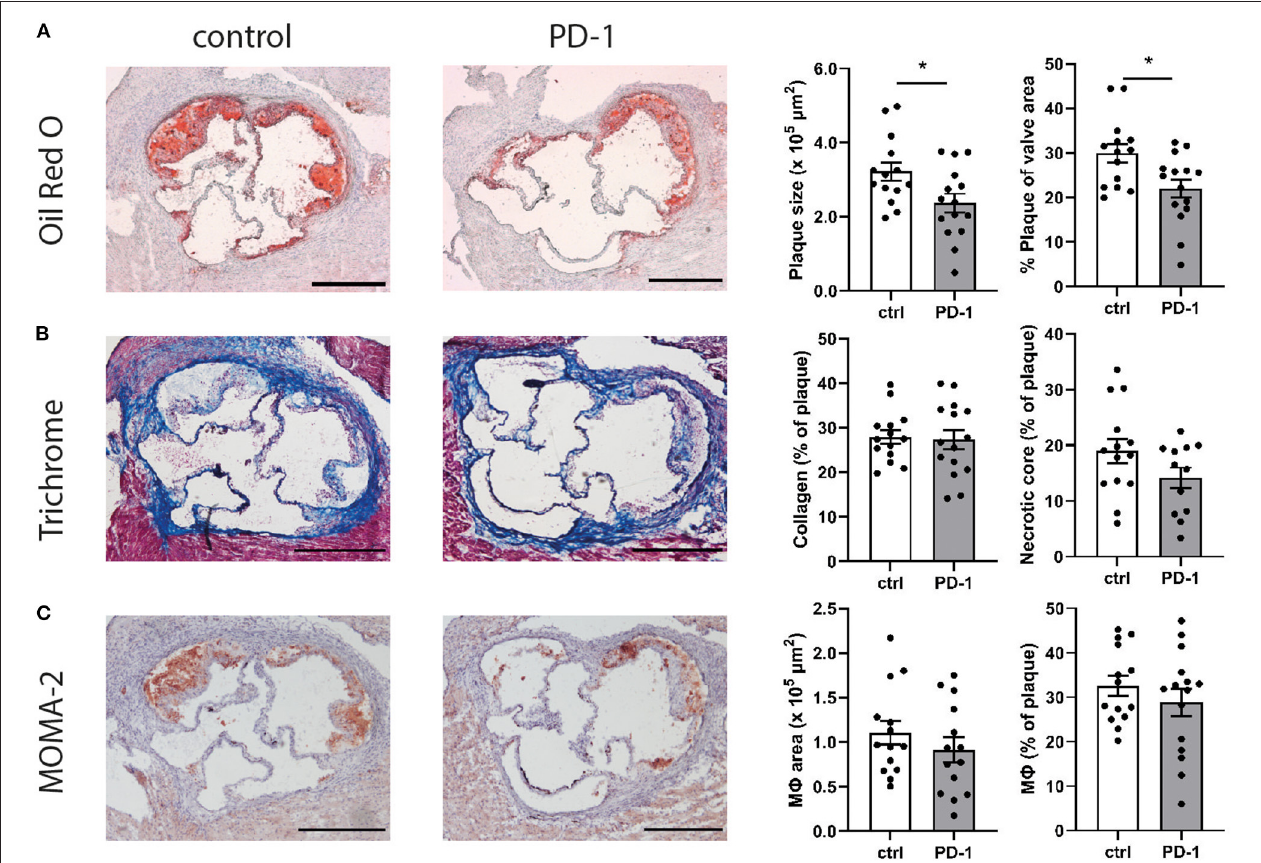
FIGURE 5 | PD-1 stimulation inhibits atherosclerosis development. Aortic root plaque size and composition was determined using an Oil-Red-O staining and representative images of the stainings are shown. Data is shown as total plaque size, and as percentage of total valve area (A) . Collagen content and necrotic core size were determined using trichrome staining, and are showed as percentage of the total plaque (B) . Macrophage content was determined using MOMA-2 antibody staining, and is shown as total MOMA-2 positive area, as well as the percentage of total plaque (C) . Scale bars indicate 250 µ m. Mean ± SEM are shown. Statistics was performed using unpaired T -test. P ≤ 0.05 are considered significant. * p ≤